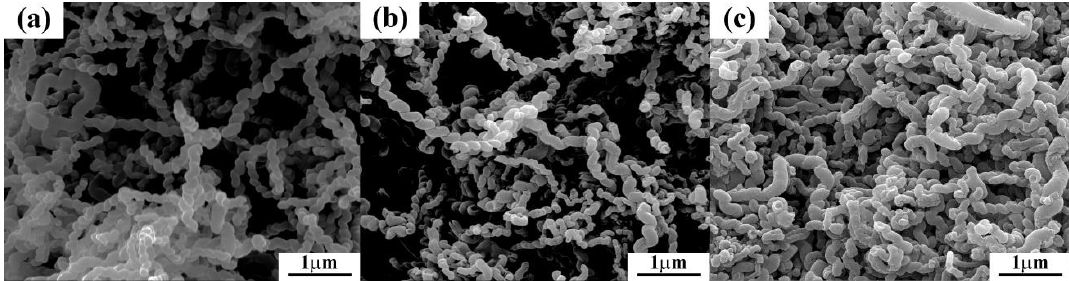
Figure 2. Scanning electron microscopy (SEM) images of P-HCNTs ( a ), A-HCNTs ( b ) and K-HCNTs ( c ).